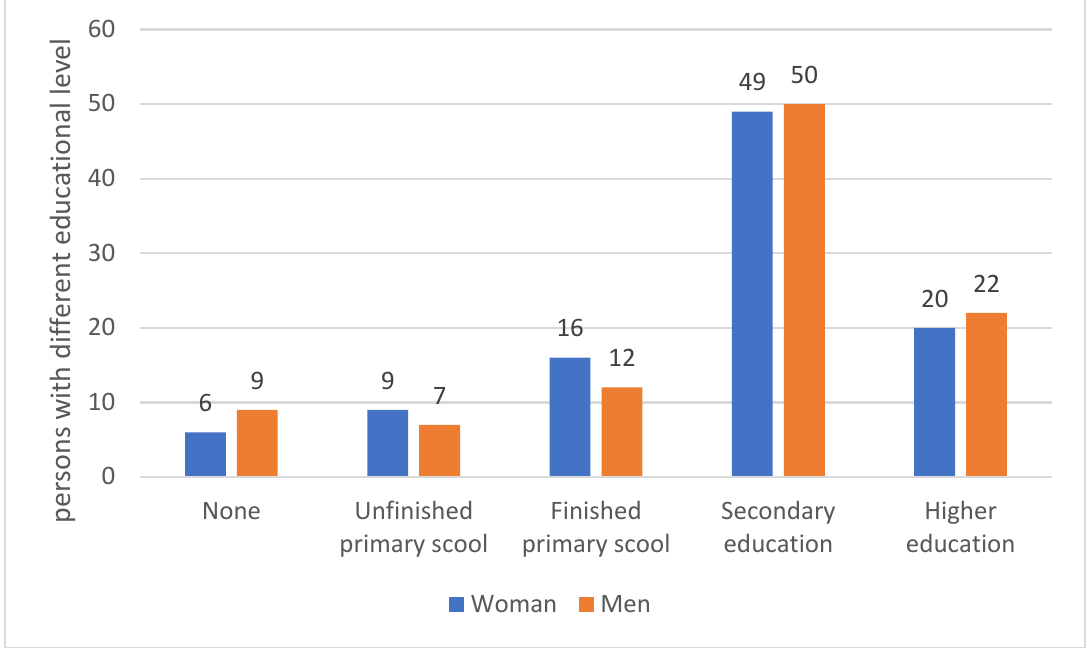
Figure 1. Educational level of the respondents.